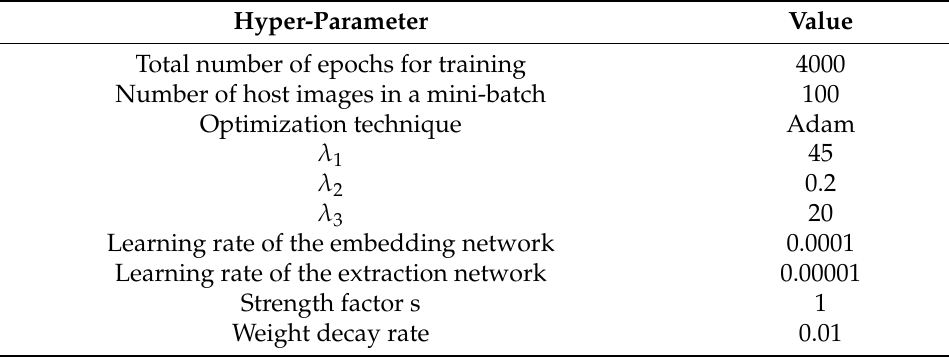
Table 5. The values of the hyper-parameters for the experiment.